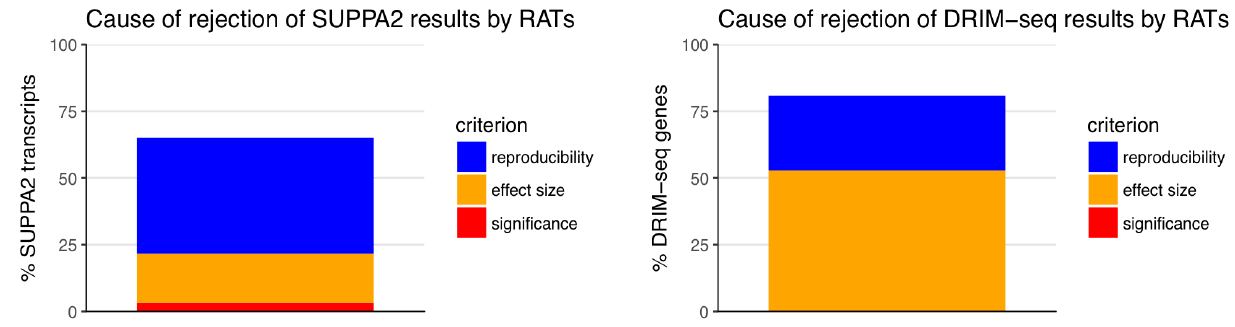
Figure 5. Causes of rejection by RATs of results reported by SUPPA2 or DRIM-Seq , expressed as proportion of the total DTU identifications reported by SUPPA2 (1252 transcripts) or DRIM-Seq (1680 genes). The colours represent the different criteria imposed by RATs . Since no abundance pre-filtering was enabled for any of the tools, there are no rejections caused by the transcript abundance and the effective number of expressed isoforms. DTU: Differential transcript usage.